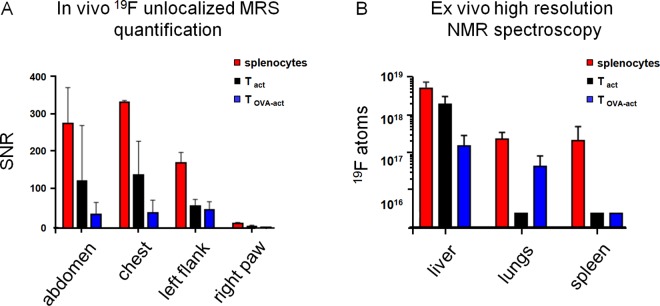
In-vivo coil-localized spectroscopy and ex-vivo high resolution NMR spectroscopy.(A) SNR (mean ±SD) of 19F coil-localized spectroscopy acquired in the four different regions of the mice. In SP injected mice higher 19F-signals were observed compared to the Tact and TOVA-act injected mice both in the abdomen and the left flank regions (p<0.05, one way ANOVA). (B) Ex-vivo 19F content (mean ±SD) in liver, lung, and spleen. No 19F signal was detected in the tumor. The internal reference (TFA) contained a known number of 19F atoms. There is a higher 19F load in the liver in SP injected compared to TOVA-act injected mice (p = 0.05: all other comparisons are non-significant). Note logarithmic scale of y-axis in B.